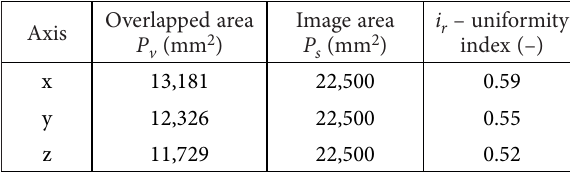
Table 2. Overlapping areas and calculation of i r